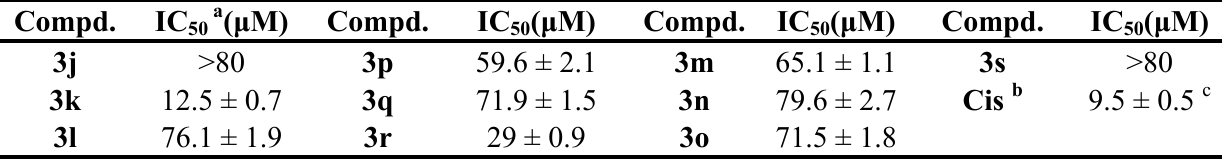
Table 2. IC values of compounds 3j–s on SW620 cells. 50